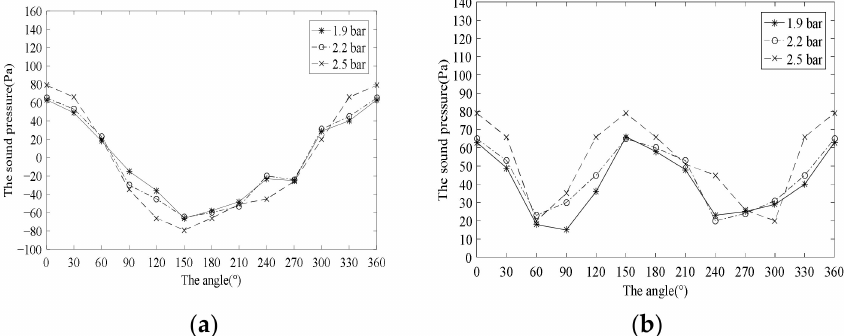
Figure 14. The sound pressure distributions: ( a ) The transient acoustic pressure distributions; ( b ) The acoustic pressure amplitudes distributions.